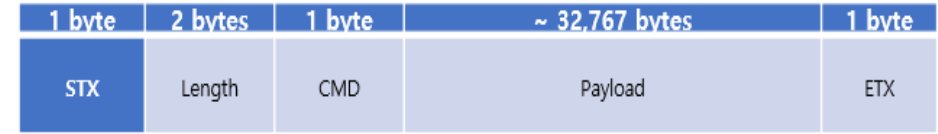
Figure 10. Message block structure of the communication protocol.